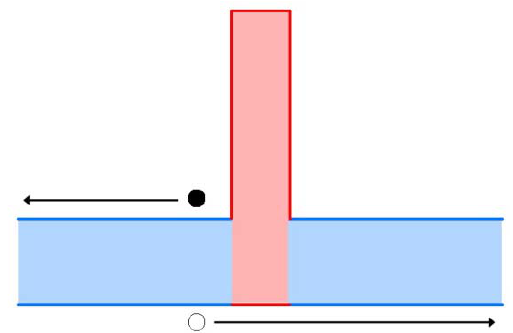
Figure 7. A band diagram of an nBn IRPD without applied bias. With the barrier in the middle, the left hand side acts as the photo-absorber. Absorbed photons create carrier pairs, which are unimpeded by the barrier. Thermally generated pairs on the right-hand side are blocked by the conduction band barrier,